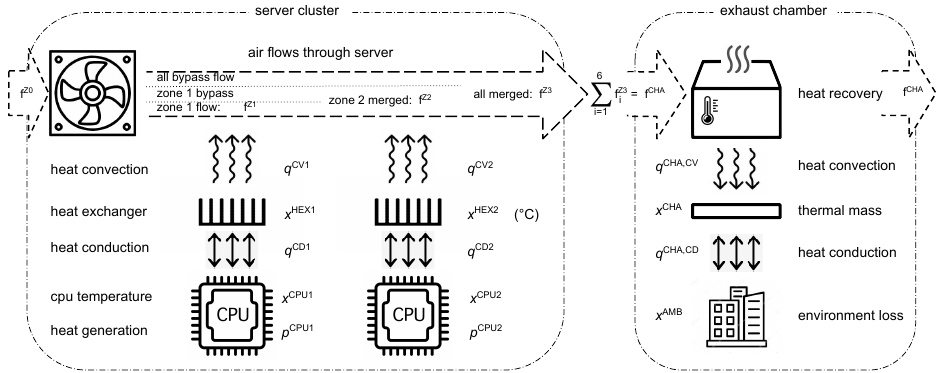
Figure 5. Conceptual illustration of the physics-informed thermal network model that is implemented as the custom cell of the physics-informed data-driven recurrent neural network (PIDD